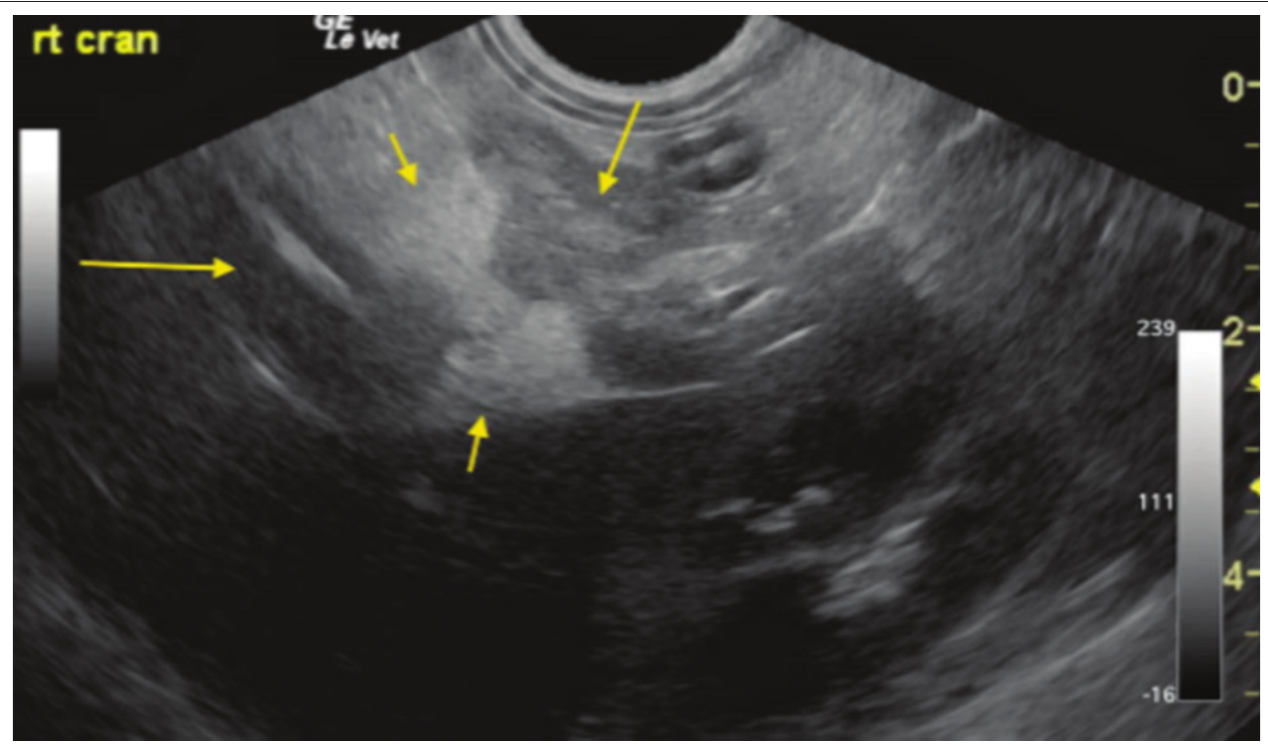
FIGURE 4: Example of pancreatitis affecting the right limb of the pancreas (group 2): Right limb pancreatitis with mixed hypoechoic oedematous parenchyma (middle arrow), ill-defined inflamed surrounding fat (short arrows), all of which surround promote inflammation of the upper descending duodenum (long arrow). Right kidney is present in far